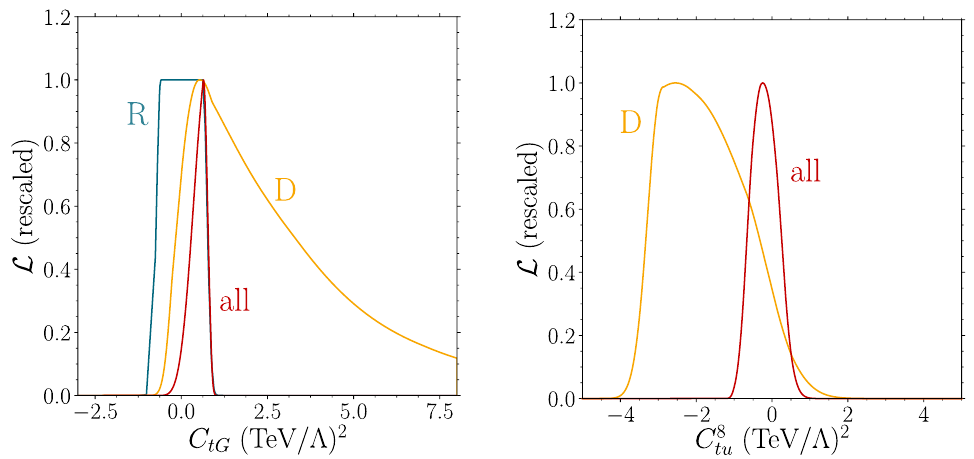
Figure 4 . Normalized likelihood as a function of C tG (left) and a C 8 LO to order (cid:3) (cid:0) 2 . We show (cid:12)ts to the R (blue) and D (yellow) observable sets of table 5, and to all t (cid:22) t observables in table 5 (red). In the right panel, we do not show the R likelihood, as it is 1 for all the values of C 8 in the displayed tu